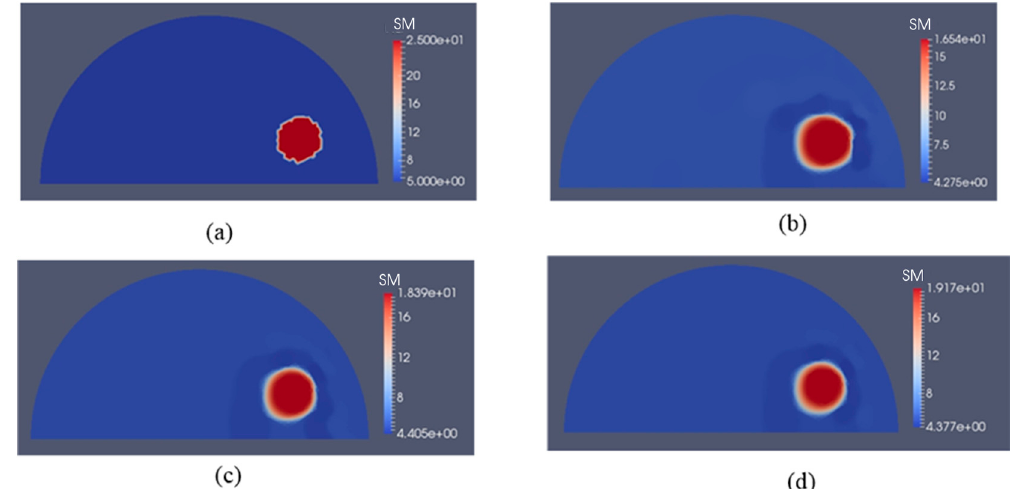
Figure 5. Shear modulus reconstructions without noise in boundary displacements. ( a ) target shear modulus distribution for comparison; ( b – d ) reconstructed shear modulus distribution using 5, 10 and 15 boundary displacement data sets, respectively (unit in the scale bar: kPa). Note: “SM” stands for shear modulus.